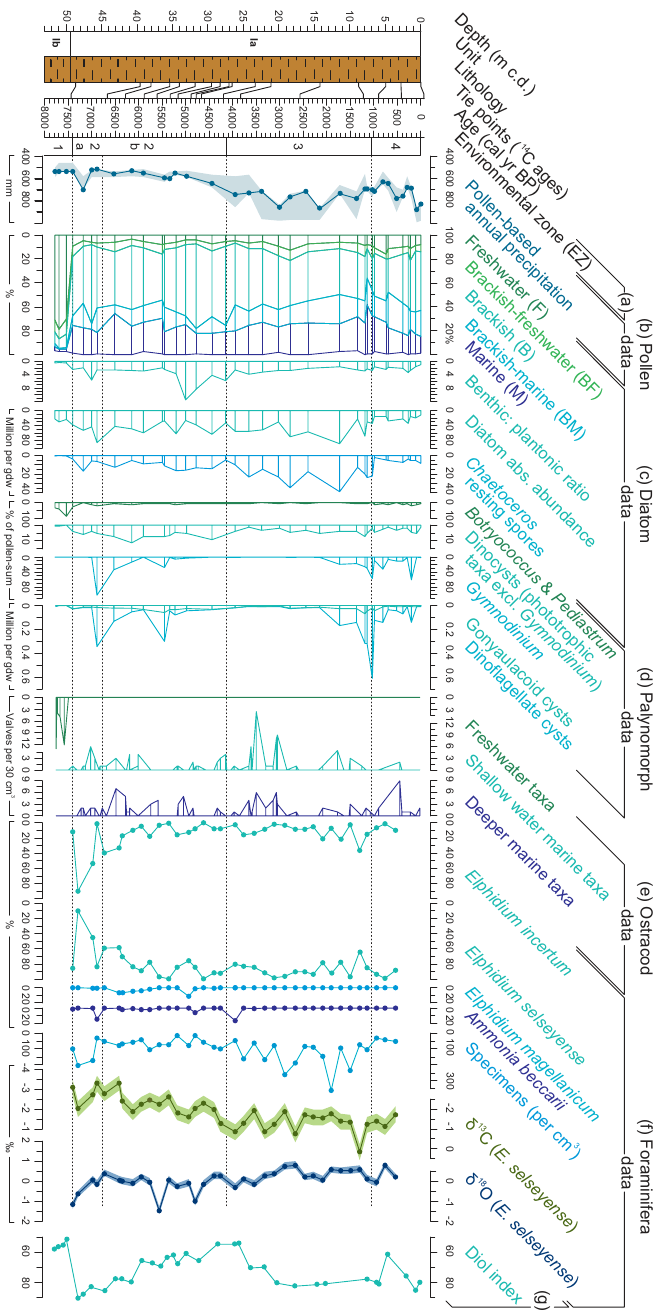
Figure 3. Sedimentological units, lithology (Andrén et al., 2015a), and position of 14 C ages (Van Helmond et al., 2017) and IODP Site M0059 precipitation and salinity proxies plotted vs. depth and age (extrapolated below ∼ 48.64 mc.d.). (a) Environmental zones (EZs) based on diatom data. (b) Pollen-based precipitation reconstructions based on the modern analogues technique. (c) Diatom salinity-based affinities and life forms (benthic vs. pelagic) following Snoeijs (1993), Snoeijs and Vilbaste (1994), Snoeijs and Potapova (1995), Snoeijs and Kasperoviciene (1996), and Snoeijs and Balashova (1998) with species assignments provided in Table S2. (d) Palynomorph / pollen ratios based on total amount of terrestrial pollen, freshwater algae comprising Botryococcus and Pediastrum species, dinocysts predominately comprising cysts of Protoceratium reticulatum ( Operculodinium cysts), Lingulodinium , and Spiniferites species ( Gymnodinium excluded). (e) Ostracod shallow water and deeper-living marine taxa plotted from right to left. (f) Total abundance of benthic foraminifera per cubic centimetre of dried sediment with the relative abundance of the most common species; benthic foraminiferal taxa ( Elphidium incertum , E. selseyense , E. magellanicum , and Ammonia beccarii ) shown as a percentage of total benthic foraminiferal fauna; total abundance of benthic foraminifera shown as specimens per cubic centimetre of dried sediment; stable carbon and oxygen isotope data analysed on E. selseyense . (g) Diol index indicating relative changes in surface water